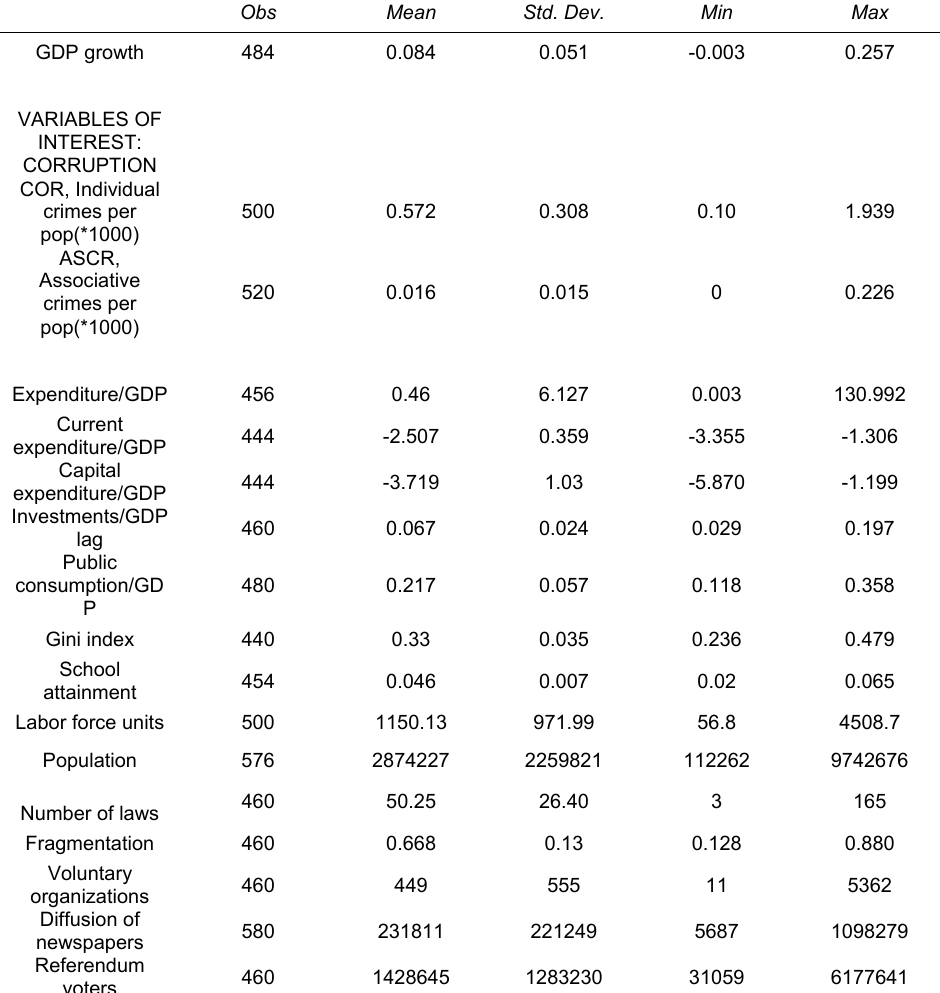
Table 2. Descriptive